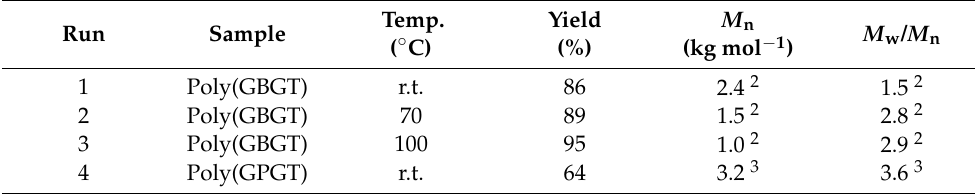
Table 1. Synthesis of Poly(GBGT) and Poly(GPGT) 1 .